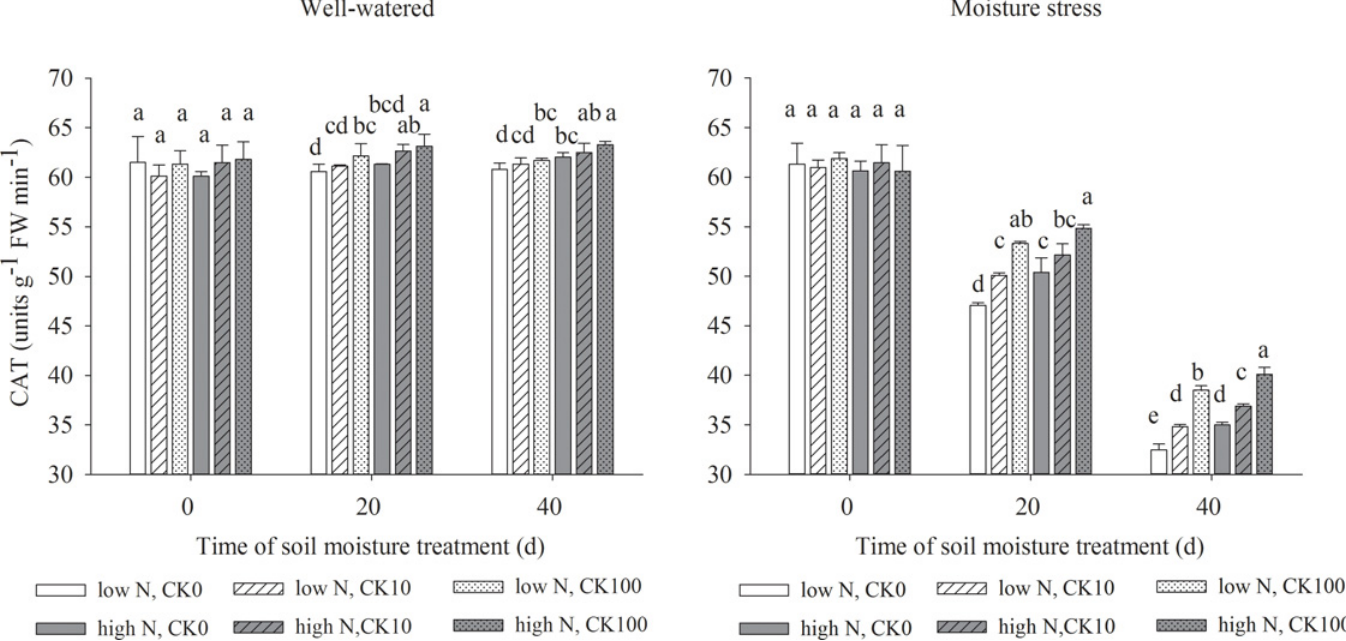
Fig 4. Activities of catalase (CAT) in leaves of drought stressed creeping bentgrass as affected by cytokinin trans -zeatin riboside (CK) and nitrogen. Bars having different letter indicate no significant enzyme activity difference (P < 0.05) between treatments on the same day.